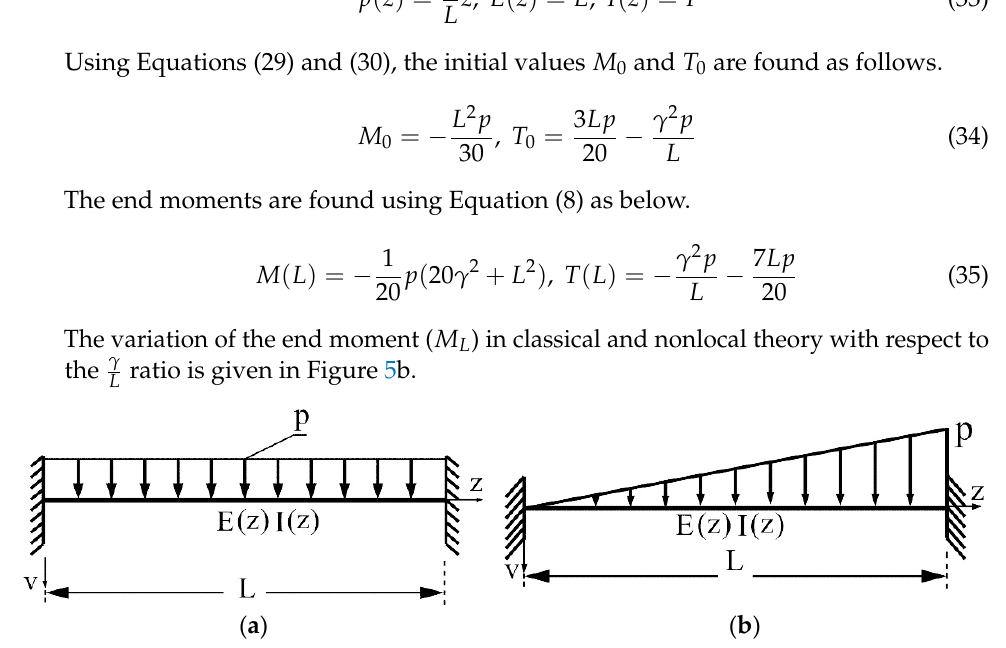
Figure 4. ( a ) Beam subjected to the uniform load; ( b ) beam subjected to the triangular load.